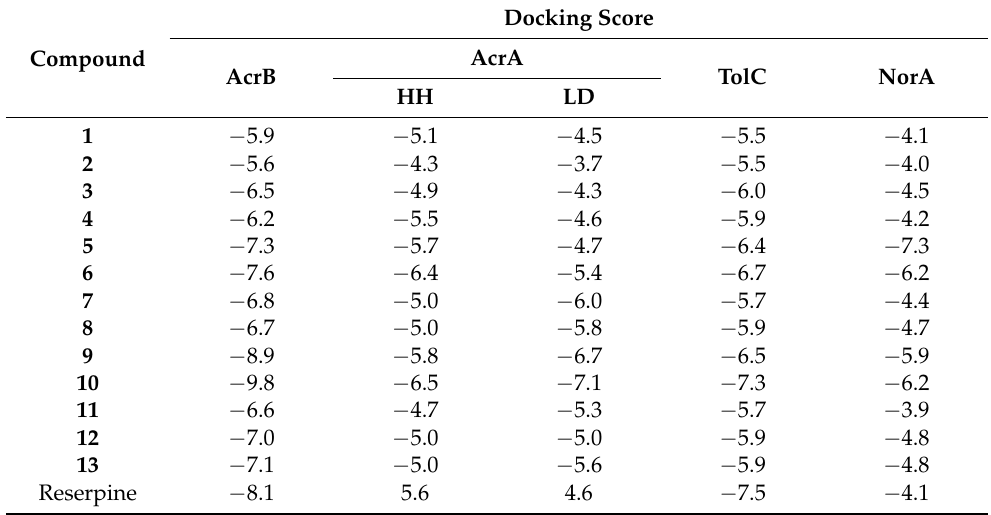
Table 1. Docking results for compounds 1–13 in the different portions of the AcrAB-TolC efflux system and the homology model of